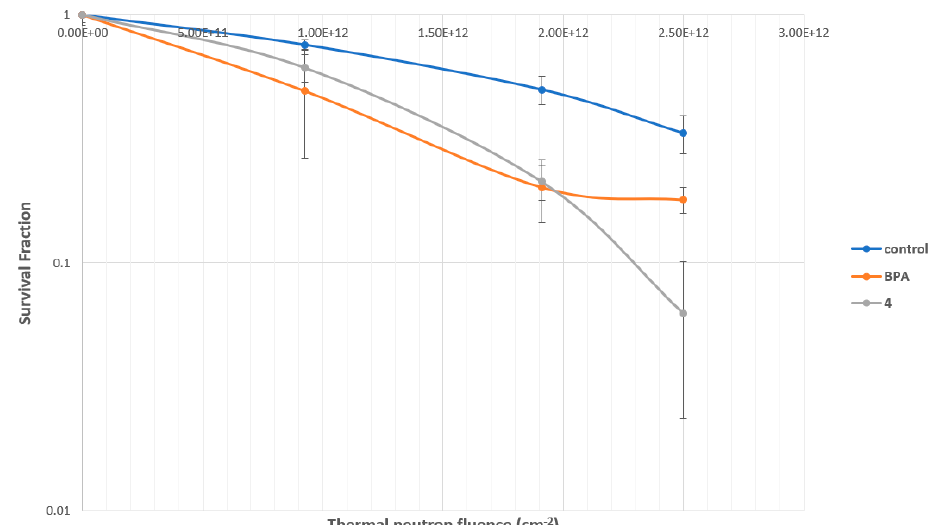
Figure 8. Survival fraction in U87 MG delta EGFR cells. BPA: 20 ppm 10 B; compound 4 : 0.48 ppm 10 B treated with U87 delta EGFR cells for 4 h.